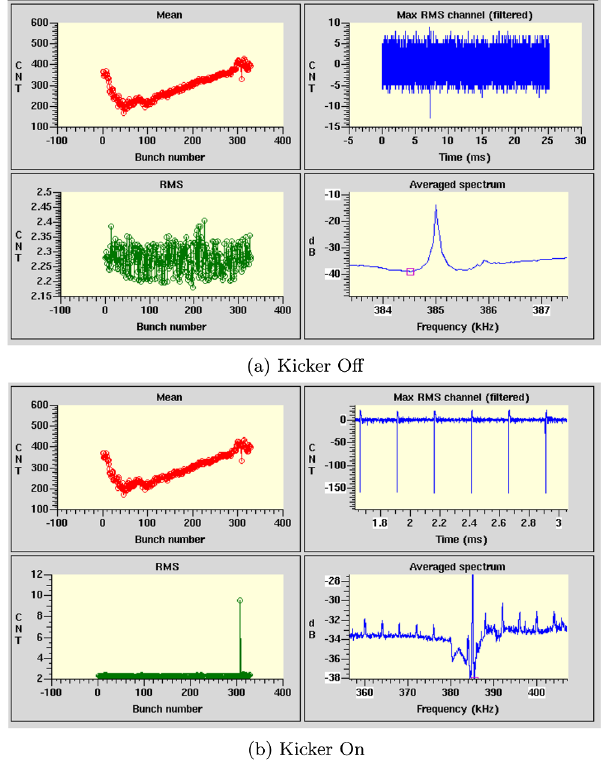
FIG. 12. Multibunch waveforms panel of the Dimtel ’ s trans- verse feedback